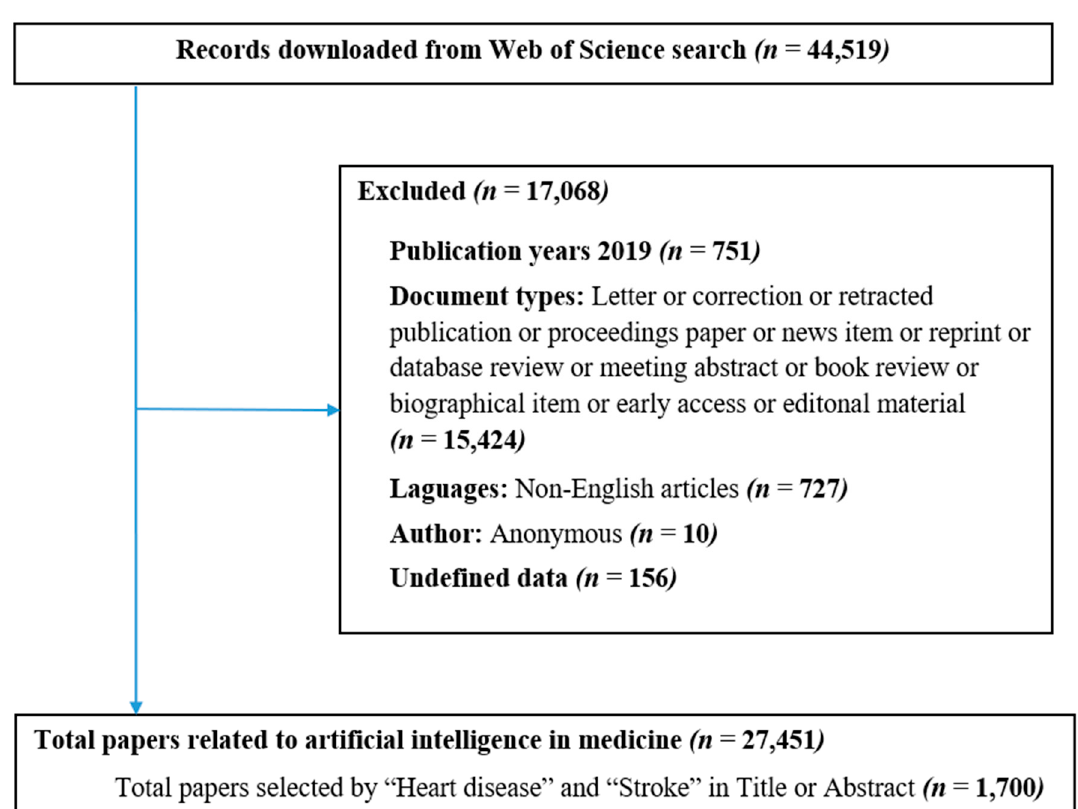
Figure 1. Paper selection process.